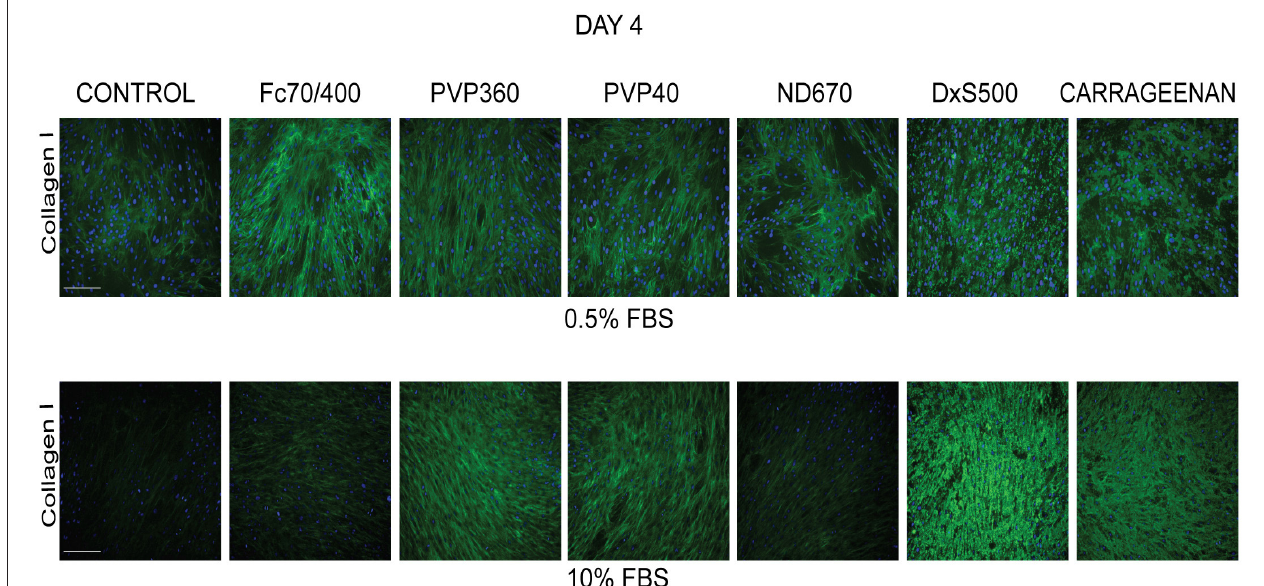
FIGURE 2 | Effect of serum concentration on collagen I deposition. Immunofluorescence staining of collagen I in human dermal fibroblasts ( n = 5) after 96h in the presence of TGF β 1 in DMEM containing 0.5 and 10% of FBS and macromolecular crowders Fc70/400 mixture, PVP360, PVP40, ND670, DxS500, and CR. Showing